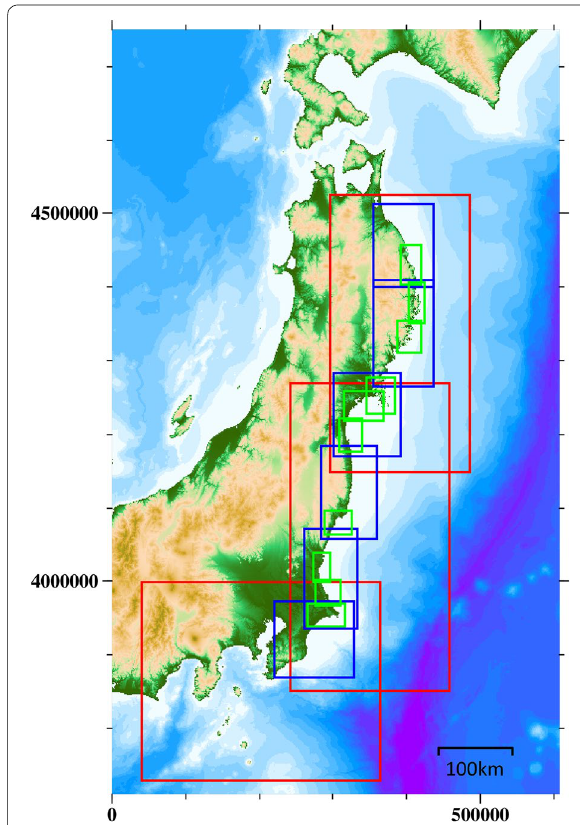
Fig. 2 The nested grid system used in this study. Red square frame indicates the computation area at 450 m grid intervals, blue 150 m, green 50